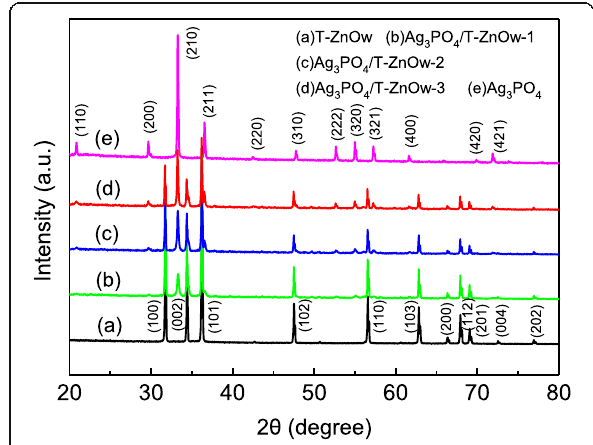
Fig. 1 XRD patterns of (a) T-ZnOw, (b) Ag 3 PO 4 /T-ZnOw-1, (c) Ag 3 PO 4 / T-ZnOw-2, (d) Ag 3 PO 4 /T-ZnOw-3, and (e) Ag 3 PO